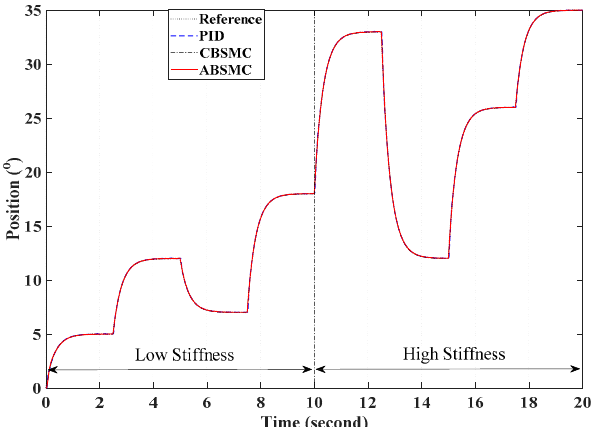
Figure 12. The angular displacement responses to the multistep reference of the manipulator with the PID control, the CBSMC, and the proposed ABSMC.